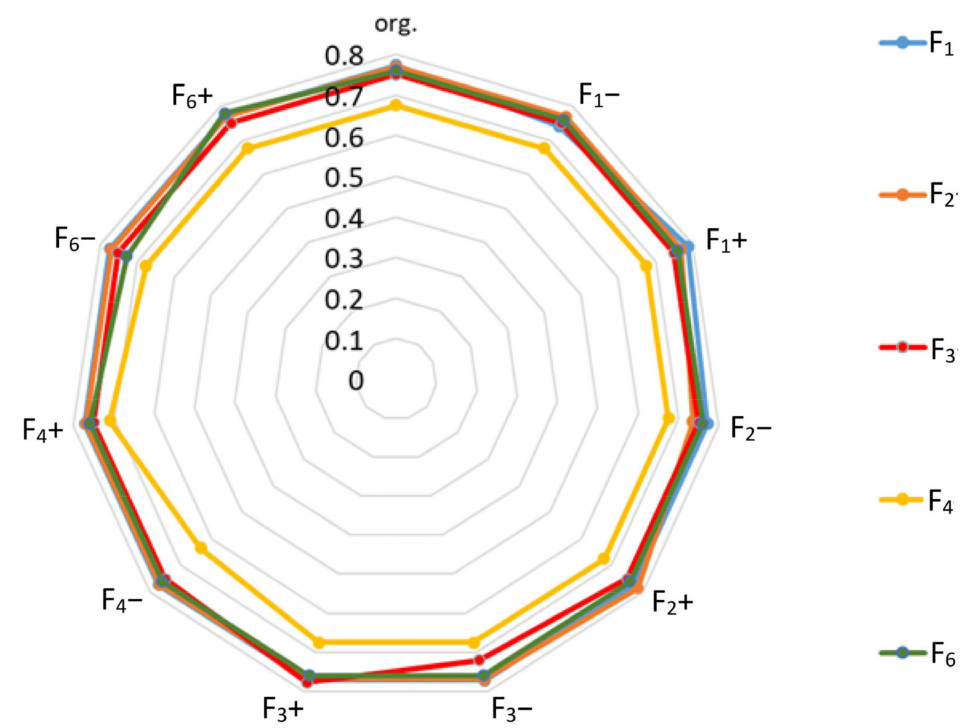
Figure 9. Sensitivity analysis results for the alternatives—closeness ratio versus factor.